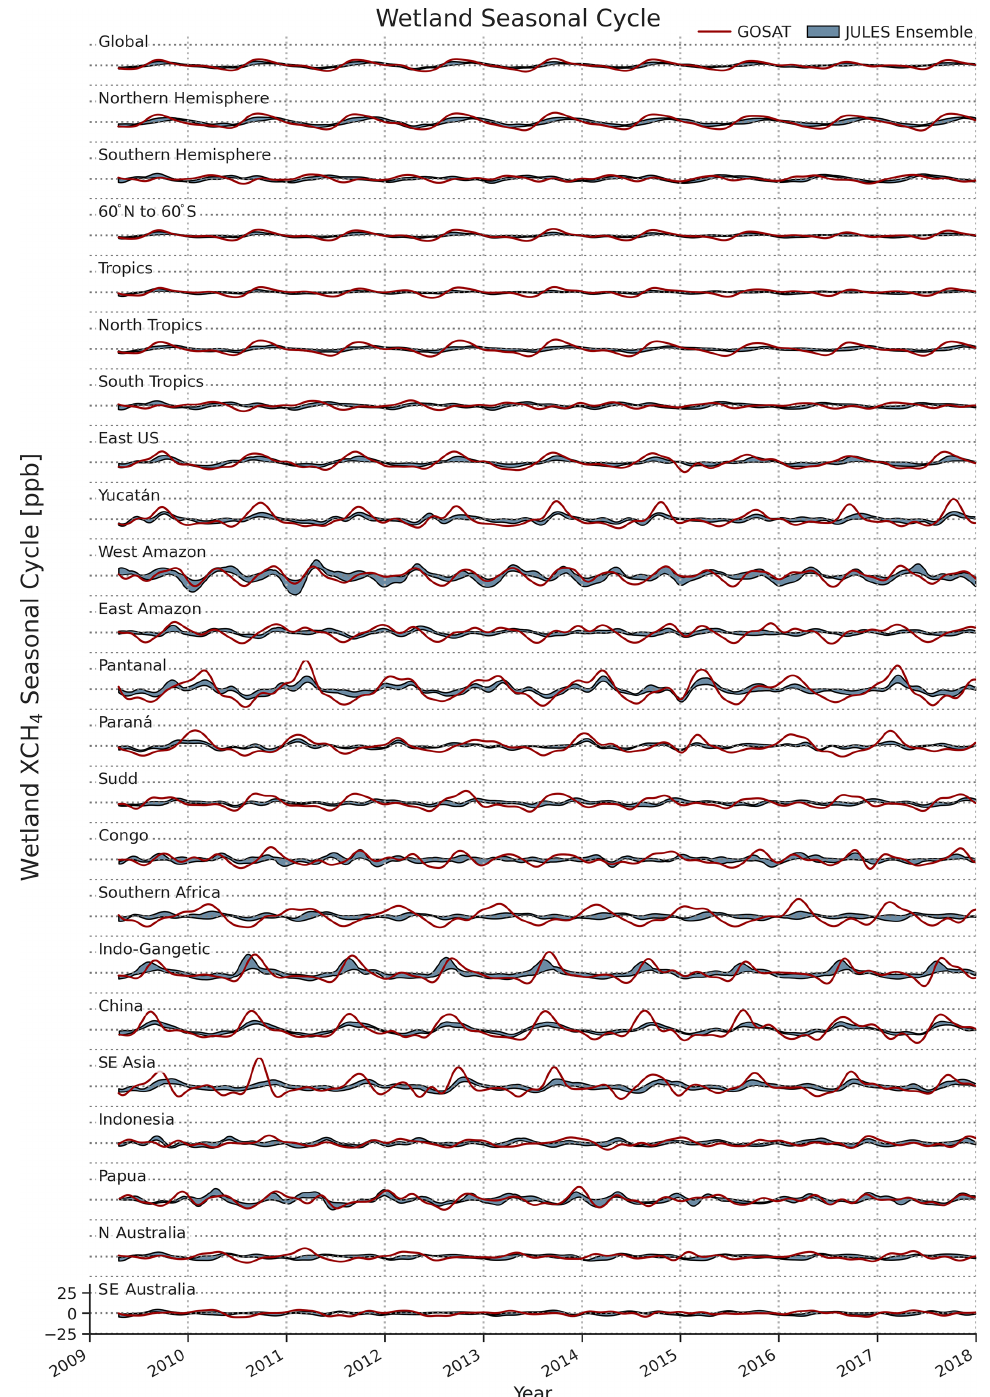
Figure 4. Time series showing the GOSAT (red) and JULES ensemble (blue, min/max envelope) wetland CH 4 seasonal cycles (inppb) for 7 large-scale areas and 16 specific wetland regions. The wetland seasonal cycle is calculated by subtracting the TOMCAT model simulations that do not contain any wetland emissions. For each time series, the dashed horizontal lines indicate the [ − 25, 0, 25] levels, as indicated in the bottom